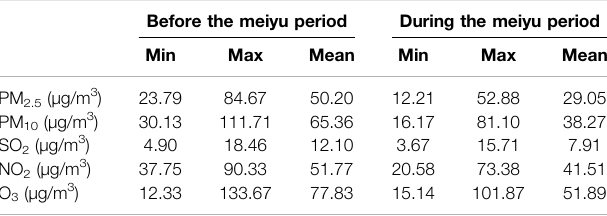
TABLE 2 | The daily average concentration of PM 2.5 , PM 10 , and gaseous pollutants before and during the Meiyu period. Before the meiyu period